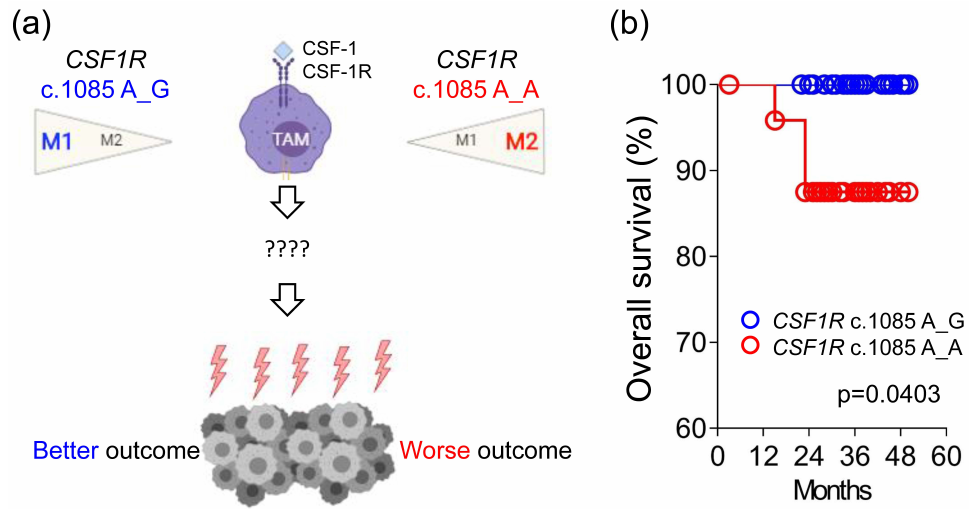
Figure 1. ( a ) Summary of the impacts of CSF1R c.1085 genotypes on the macrophage polarization and clinical outcome of cancer patients. The detailed mechanisms mediating the different outcome remain unknown. TAM, tumor-associated macrophage; CSF-1, colony stimulating factor 1; CSF-1R, colony stimulating factor 1 receptor. ( b ) Overall survival of CRC patients with different CSF1R c.1085 genotypes. Kaplan–Meier curves of overall survival in CRC patients with CSF1R c.1085 genotype A_A and A_G are shown and were compared by log-rank